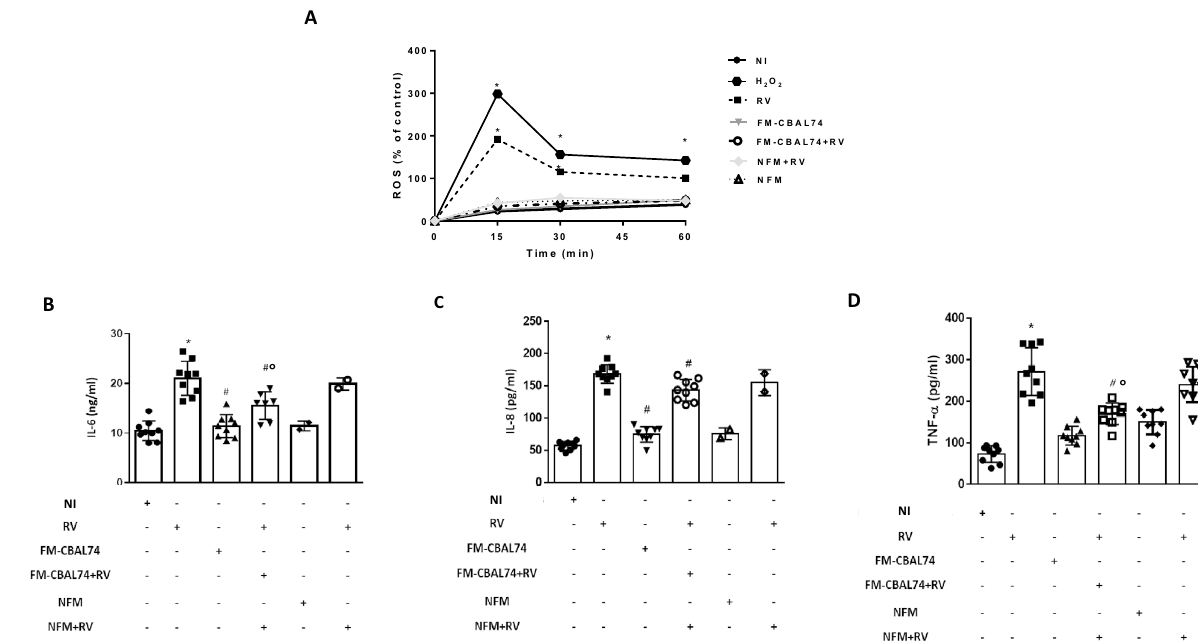
Figure 4. Effects of FM-CBAL74 on ROS and pro-inflammatory cytokines production in Rotavirus -infected human enterocytes. (A) Caco-2 cells were infected with RV and pretreated with FM-CBAL74 or NFM for 48 h. RV induced a significant increase in ROS production in a time-dependent manner. Pre-incubation with FM-CBA L74 (FM-CBAL74 + RV), but not with NFM (NFM + RV), significantly inhibited the RV-induced increase in ROS. H 2 O 2 served as a positive control. (B–D) Caco-2 cells were infected with RV and pretreated with FM-CBAL74 or NFM for 48 h. The supernatants were collected for ELISA assays. RV elicited a significant increase in IL-6 (B) , IL-8 (C) and TNF-α (D) production. Pre-incubation with FM-CBAL74 (FM-CBAL74 + RV), but not with NFM (NFM + RV), significantly inhibited the RV-induced increase in IL-6, IL-8 and TNF-α production in Caco-2 cells. Data represent the means with SD of 3 independent experiments, each performed in triplicate. Data were analyzed using the one-way ANOVA test. *p < 0.05 vs non-infected cells (NI); # p < 0.05 vs RV-infected cells; °p < 0.05 vs NFM + RV. RV Rotavirus, FM-CBAL74 fermented milk L. paracasei CBAL74, NFM not fermented cow